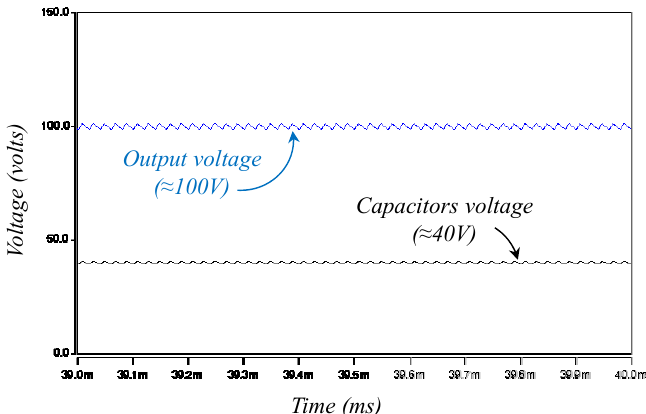
Figure 13. Output voltage and the voltage across capacitors.